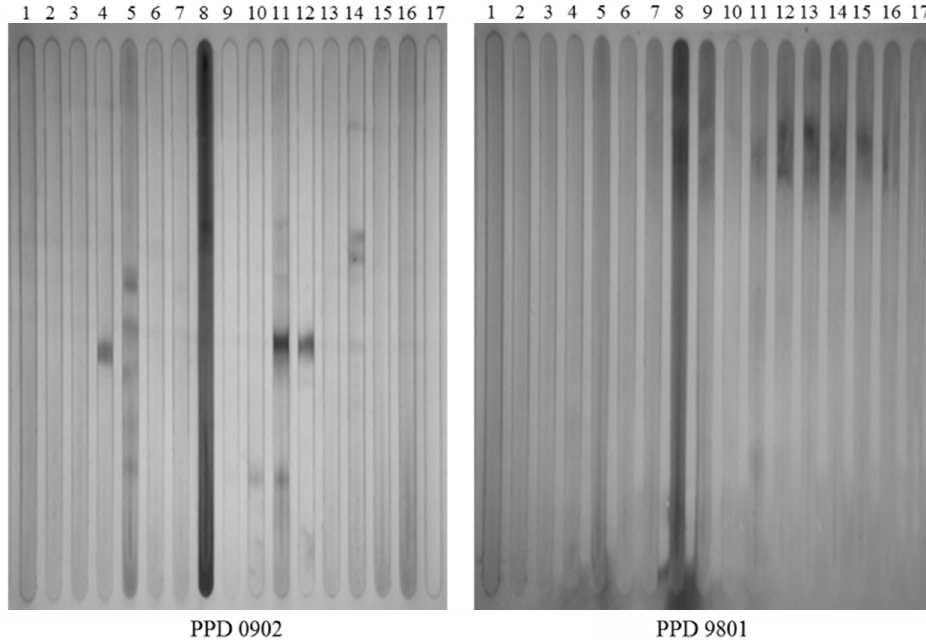
Fig 2. Comparative antibody responses between the PPD production methods. Immunoblots of PPD 0902 produced by an alternative production method on the left and PPD 9801 produced by the traditional method on the right. Both blots were exposed to identical bovine serum samples loaded into independent slots. Note that distinct antigenic bands appear in the alternate PPD preparation. Lanes 1 – 15 cattle positive for Johne ’ s disease, Lanes 16 & 17 cattle negative for Johne ’ s disease. Lane numbers correspond to cattle listed in Table 1.